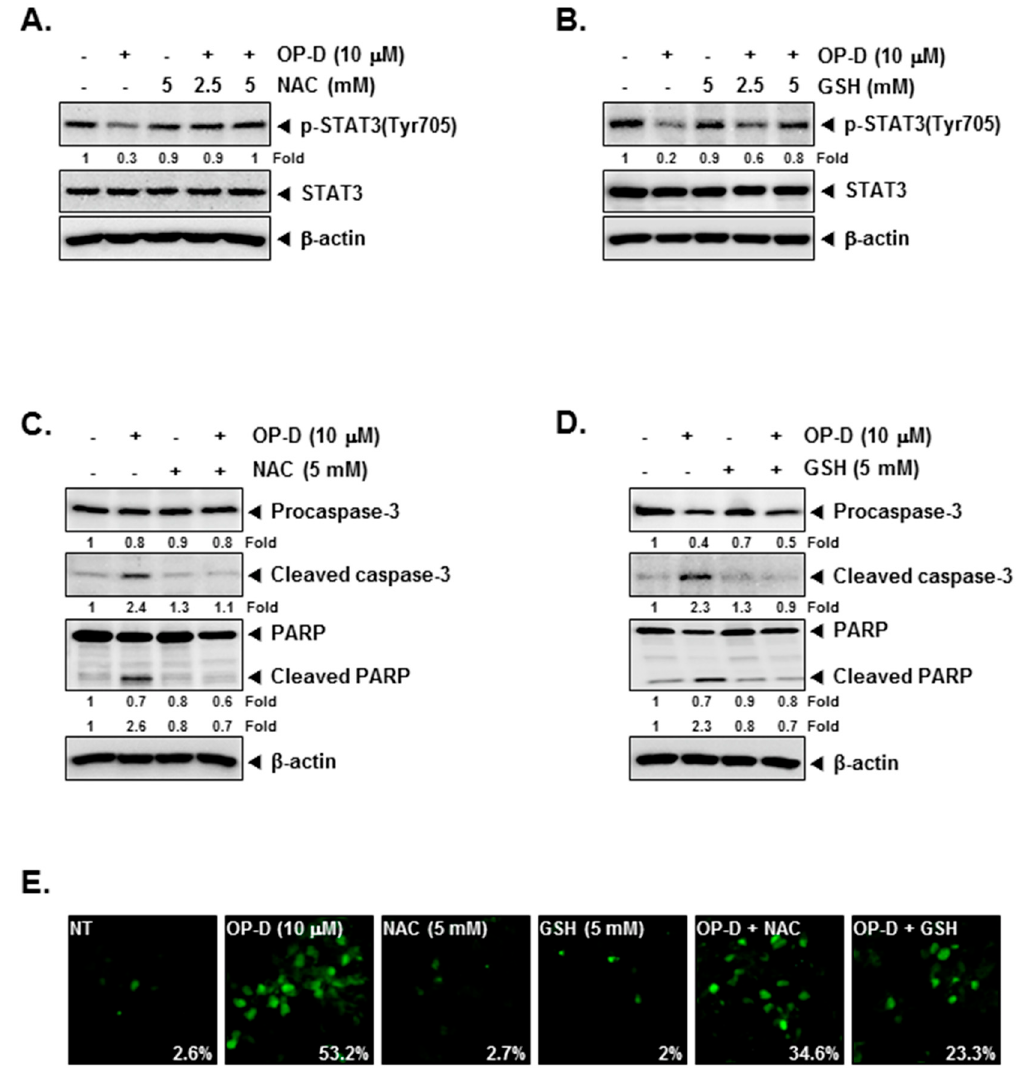
Figure 4. N -acetyl- L -cysteine (NAC) and glutathione (GSH) can reverse the STAT3 inhibition. ( A , B ) A549 cells were pretreated with indicated concentrations of NAC or GSH for 30 min, and then treated with 10 µ M of OP-D for 6 h followed by Western blot analysis. ( C , D ) A549 cells were pretreated with 5 mM of NAC or 5 mM of GSH for 30 min, and then exposed to OP-D (10 µ M) for 24 h followed by Western blot. ( E ) A549 cells were pretreated with 5 mM of NAC or 5 mM of GSH for 30 min, and then exposed to OP-D (10 µ M) for 24 h, harvested, fixed, incubated with a TUNEL reaction solution, and analyzed using a confocal microscope.